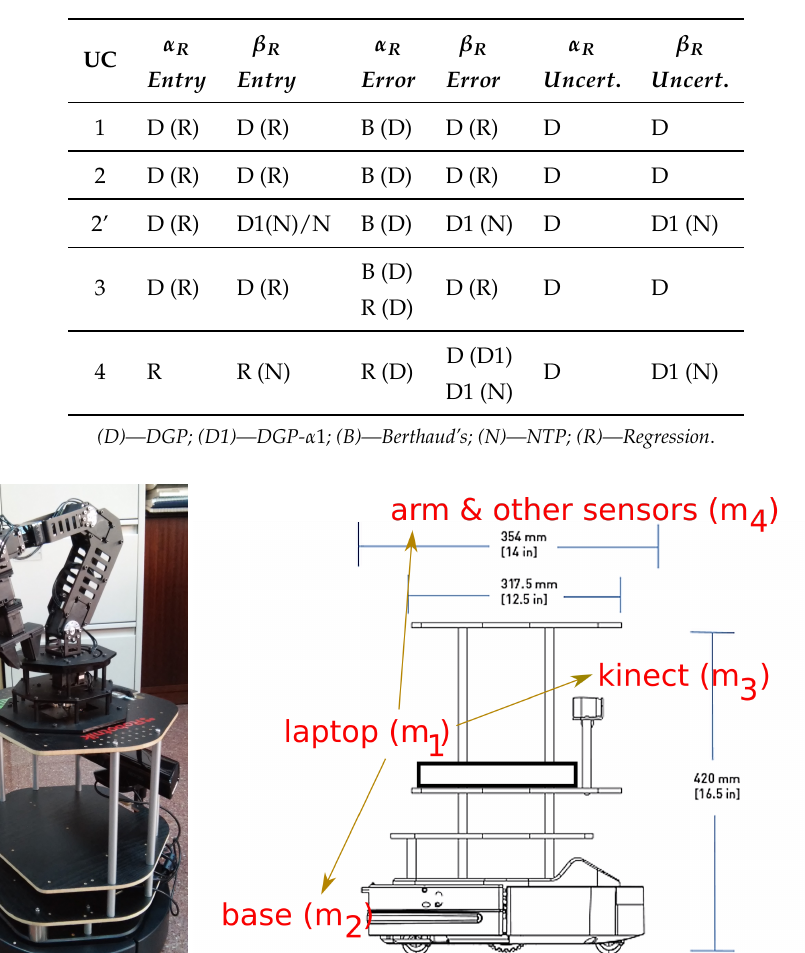
Table 9. Recommended synchronization methods for the use cases in Section 3.4.